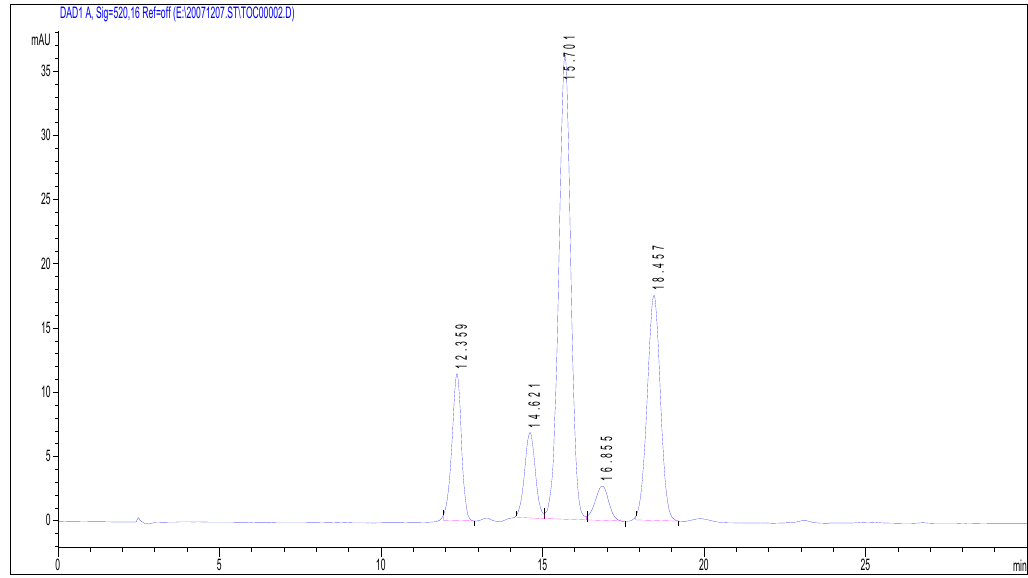
Figure 1. HPLC chromatogram at 520 nm for 60% methanol fraction (F1) obtained from the whole cranberry extract (WCE). Anthocyanins identified from retention times for cyanidin galactoside (12.3 min); cyanidin arabinoside (14.6 min); peonidin galactoside (15.7 min); peonidin arabinoside, (18.5 min) according to previous studies